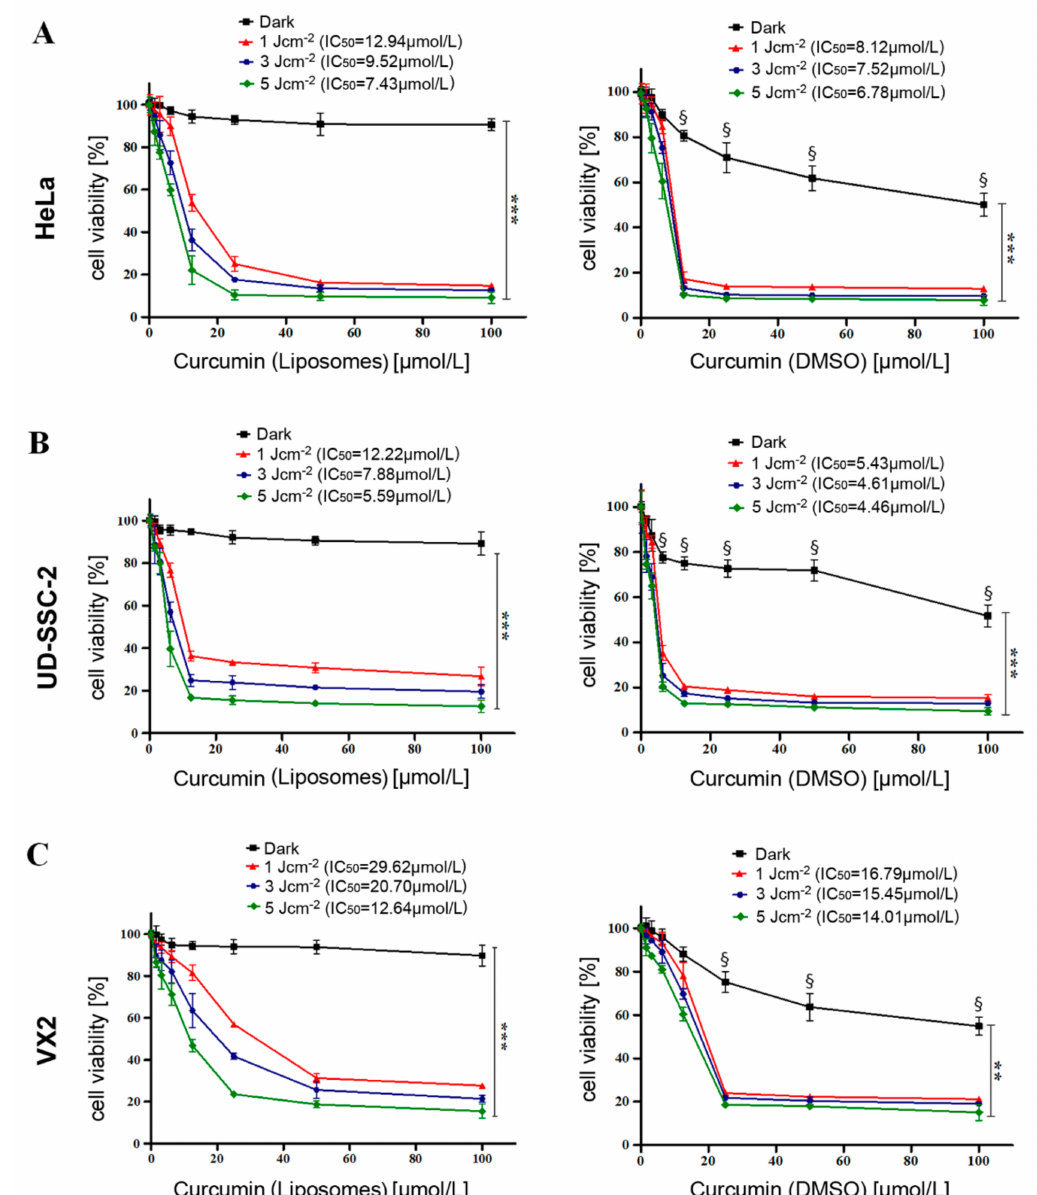
Figure 2. Evaluation of cellular viability in HeLa, UD-SCC-2, and VX2 cells. Cellular viability was assessed with the MTT (3-(4,5-dimethylthiazol-2-yl)-2,5-diphenyltetrazolium bromide) assay to determine the dark toxicity and phototoxicity of curcumin-loaded liposomes ( A, B, and C left ) and free curcumin using dimethyl sulfoxide (DMSO) as a vehicle ( A, B, and C right ). Dark toxicity and phototoxicity were determined by incubation of curcumin liposomes and free curcumin (in DMSO) for 4 h in the concentration range of 0–100 µ mol / L at light fluences of 1, 3, and 5 J · cm − 2 . Dark refers to untreated cells (0 µ mol / L curcumin) and cells treated with free curcumin (in DMSO) or curcumin liposomes without photodynamic therapy (PDT). The half maximal inhibitory concentration (IC 50 ) values were calculated by nonlinear curve fitting for each light fluence. All samples were measured in triplicate, and the data are expressed as mean ± standard deviation. Statistical significances are indicated as *** p < 0.001, ** p < 0.01. § denotes that the viability of cells treated with free curcumin (in DMSO) is significantly ( p < 0.001) lower than in the corresponding curcumin (liposomes)-treated